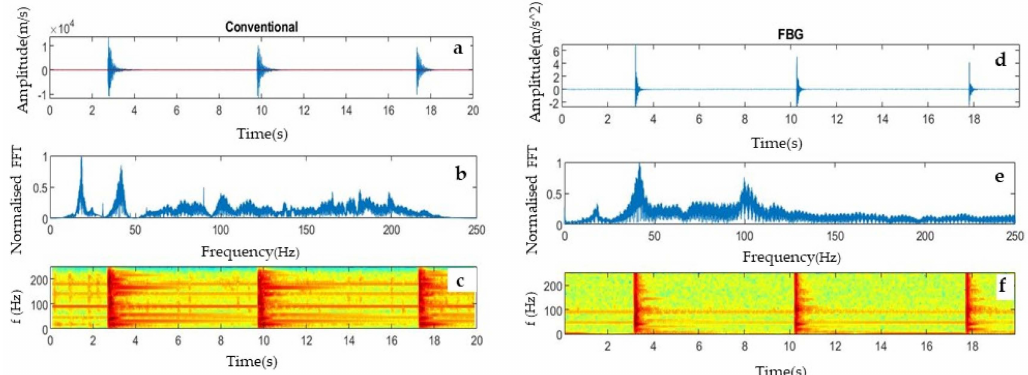
Figure 3. Exemplificative comparison of time- and frequency- domain signals from the conventional geophone ( left ) and the FBG system ( right ) in the preliminary laboratory test. ( a ) Amplitude of the signal of the conventional geophone in the time domain; ( b ) normalized amplitude spectrum, ( c ) spectrogram, ( d ) amplitude of the signal of FBG accelerometer in the time domain; ( e ) normalized amplitude spectrum, ( f ) spectrogram.